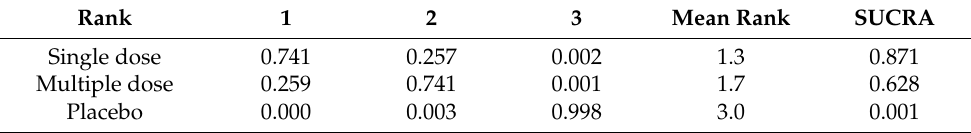
Table 4. Rank probability and surface under the cumulative ranking (SUCRA) curve result.